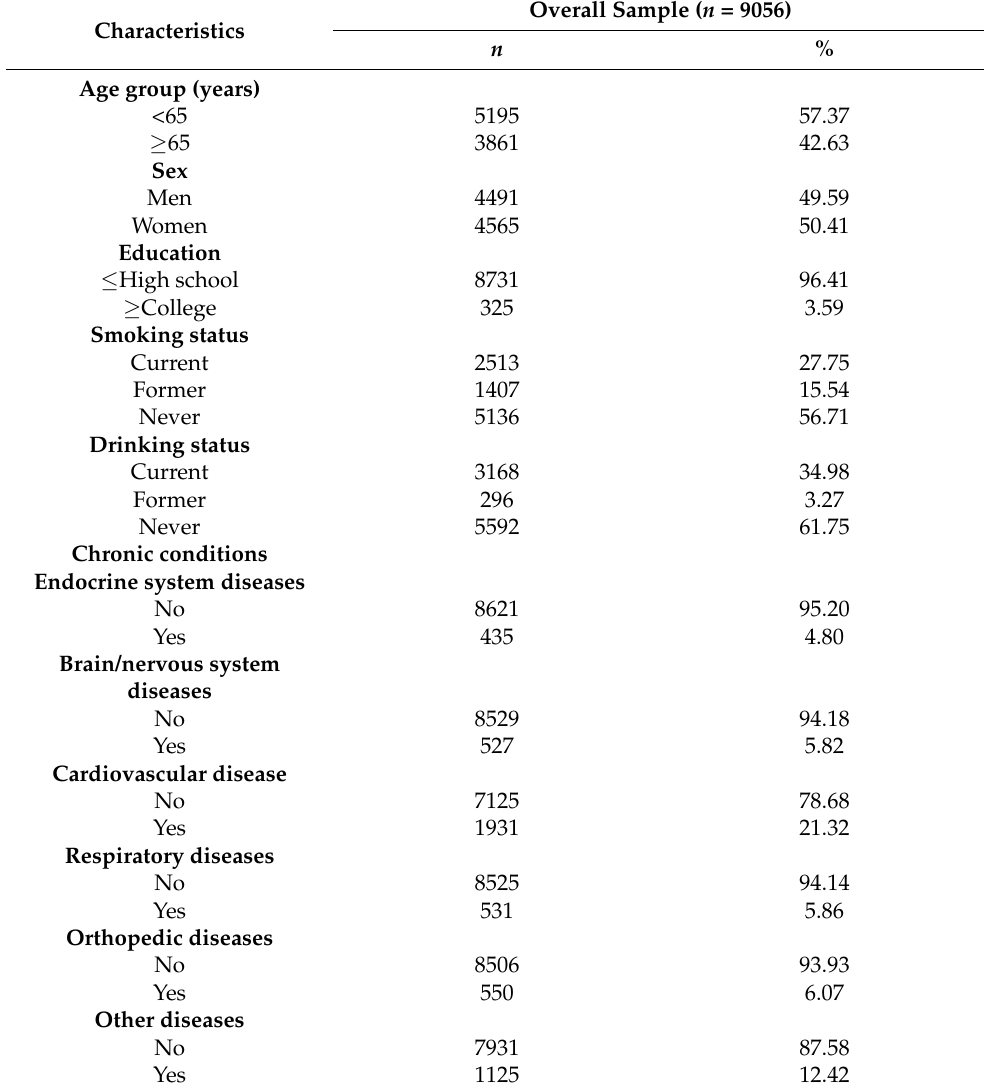
Table 1. Basic characteristics of